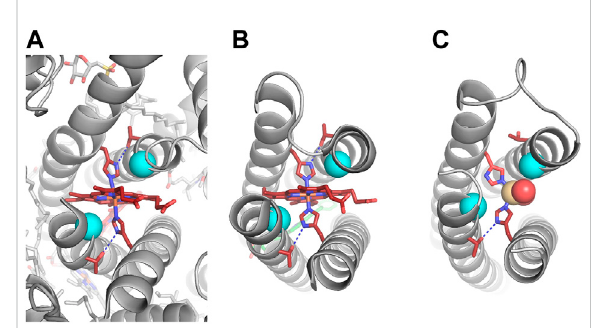
FIGURE 7 Experimental structures with and without heme. Heme B, ligating His residues, and second-shell Thr residues are shown in dark red. Notch Gly residues that make van der Waals contact with the porphyrin ring have C α atoms shown in cyan. Hydrogen bonds are indicated by dashed blue lines. (A) Cryo-electron microscopy structure of spinach cytochrome b 6 f (PDB ID: 6RQF) (Malone et al., 2019). (B) X-ray crystal structure of RC maquette withhemeBandaZnporphyrin(PDBID:5VJS)(Ennistetal.,2022). (C) X-ray crystal structure of RC maquette without heme B at 1.78 Å resolution (PDB ID: 8D9O). Cd(II) is shown as a tan sphere coordinated by the two histidines and two water molecules (red spheres). In the heme-free structure, the A -site is narrower, and theimidazoleringofHis110is fl ipped,breakingthehydrogenbond to Thr91.